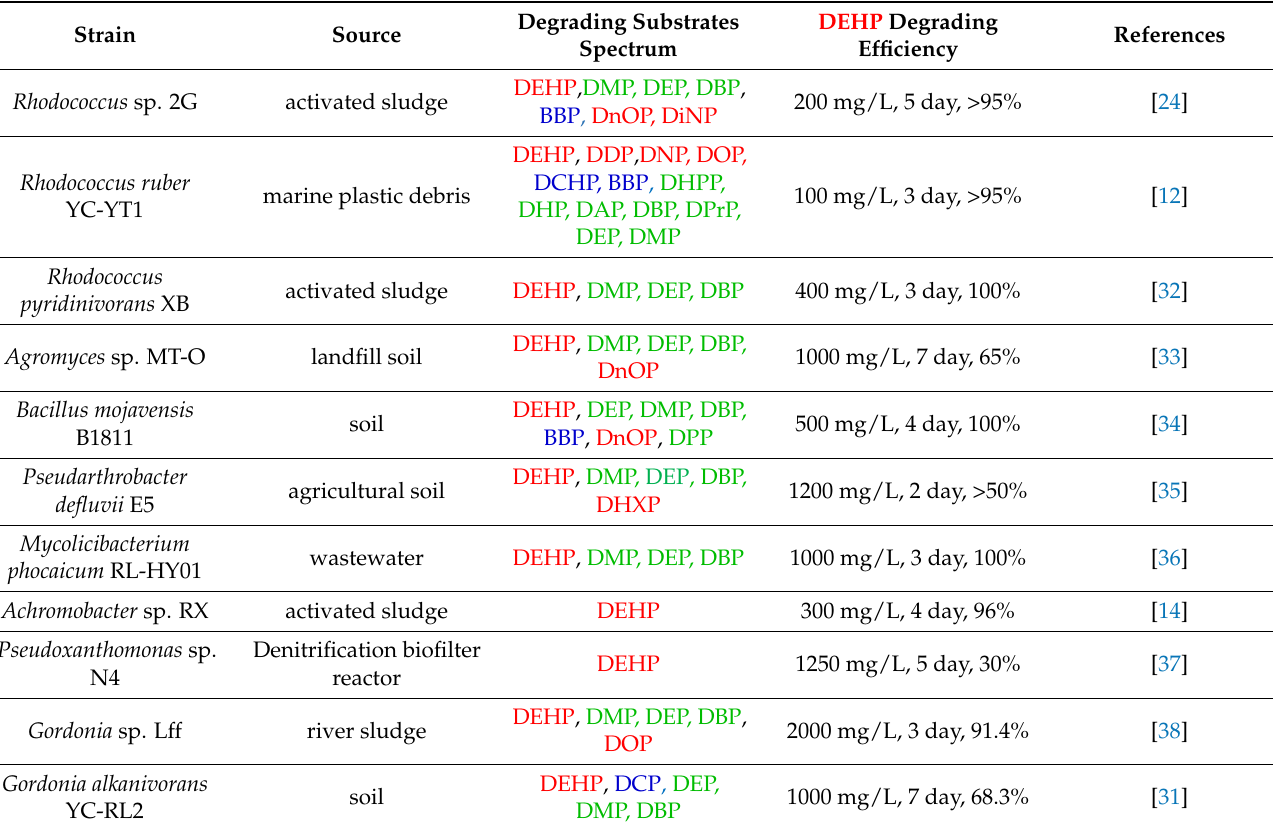
Table 1. Comparison between the strain GZ-YC7 and reported DEHP-degrading